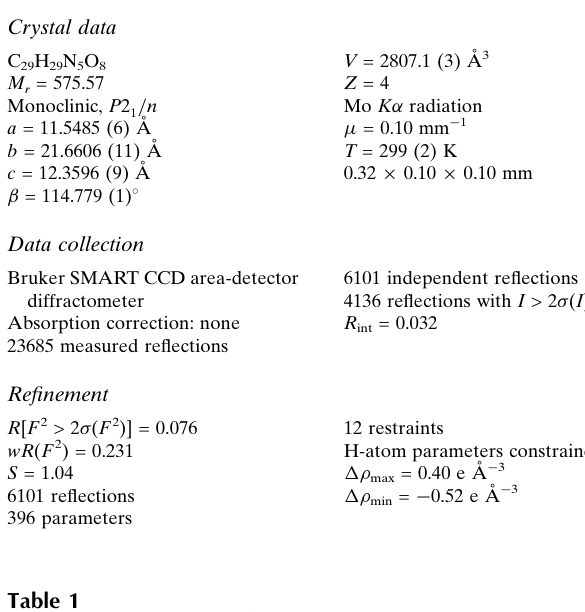
Hydrogen-bond geometry (A˚ , (cid:1)